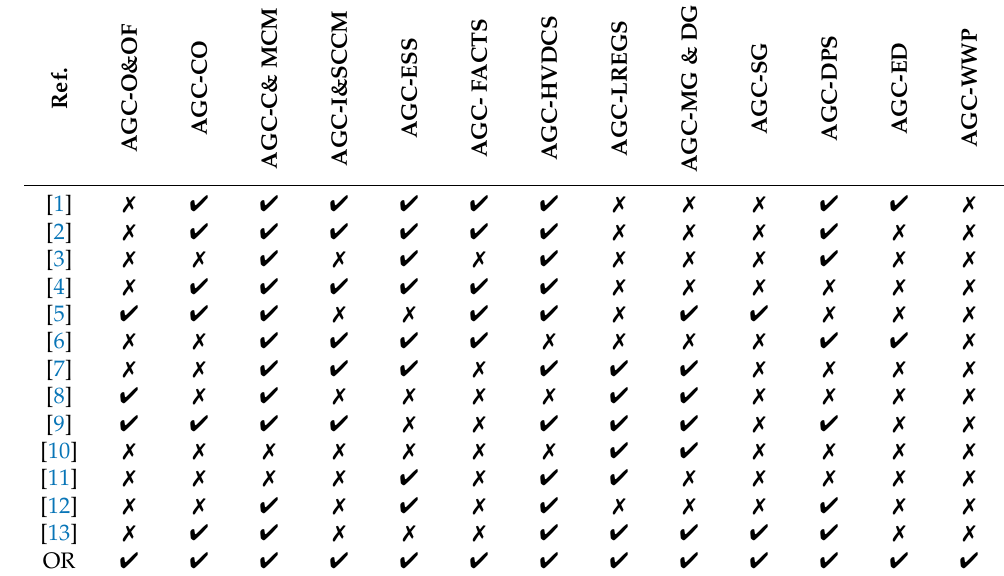
Table 1. Summary of some generic state-of-the-art work on